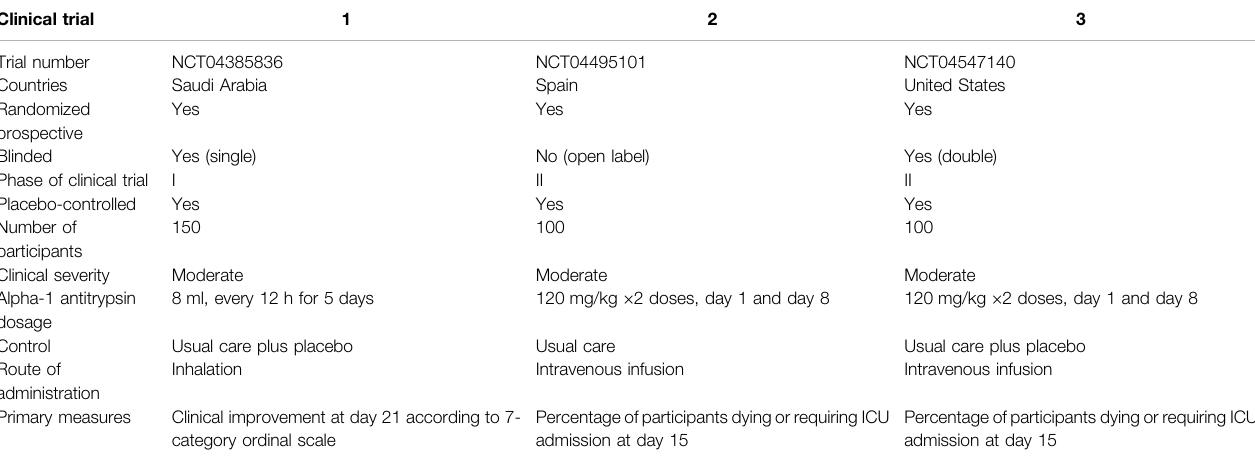
TABLE 2 | Approved alpha-1 antitrypsin clinical trials for COVID-19 treatment. Clinical